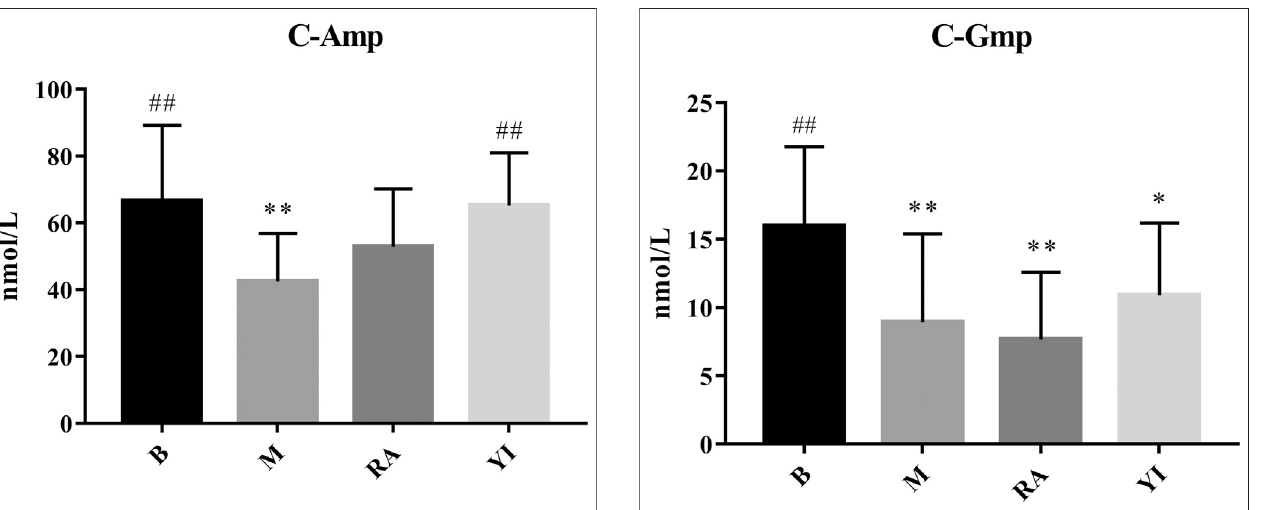
FIGURE11| Changesofserumc-GMPlevels.B,blankgroup;M,model group;RA,ULRAgroup;YI,YFgroup.ComparedwithBgroup,*: p < 0.05,**: p < 0.01; Compared with M group, ##: p < 0.01. c-GMP, cyclic guanine monophosphate; ULRA, unprocessed lateral root of Aconitum carmichaelii ; YF,